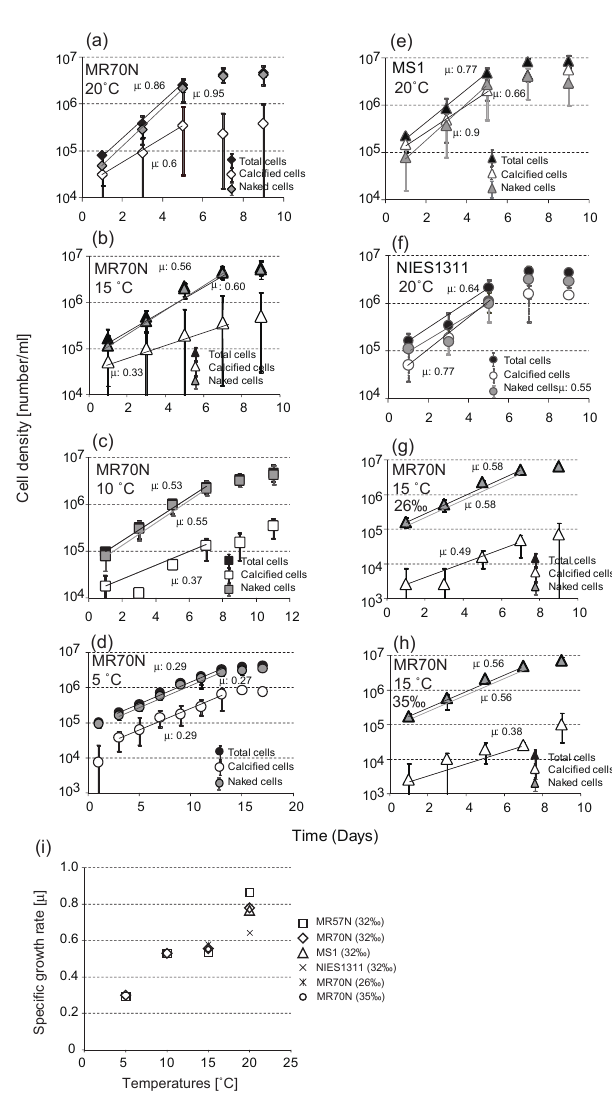
Figure 1. Growth responses of an Arctic strain of E. huxleyi (strain MR70N) to changes in temperature and salinity, (a) growth curves of E. huxleyi at 20 ◦ C and a salinity of 32‰; (b) at 15 ◦ C; (c) at 10 ◦ C; (d) at 5 ◦ C; (e) growth curves of E. huxleyi strain MS1 at 20 ◦ C; (f) growth curves of E. huxleyi strain NIES1311 at 20 ◦ C; (g) growth curves of E. huxleyi strain MR70N at 26‰ salinity; (h) growth curves of E. huxleyi strain MR70N at 35‰ salinity. Solid, gray, and white symbols indicate whole culture (naked + calcified cells), non-calcified (naked), and calcified cells, respec- tively. (i) Effect of growth temperature on the specific growth rates of whole cells of E. huxleyi strains MR57N (squares), MR70N (di- amonds), MS1 (triangles), and NIES1311 (crosses) at 32‰, and MR70N at 26‰ (asterisks) and 35‰ (circles). For µ values, see graphs (a–h) and Table